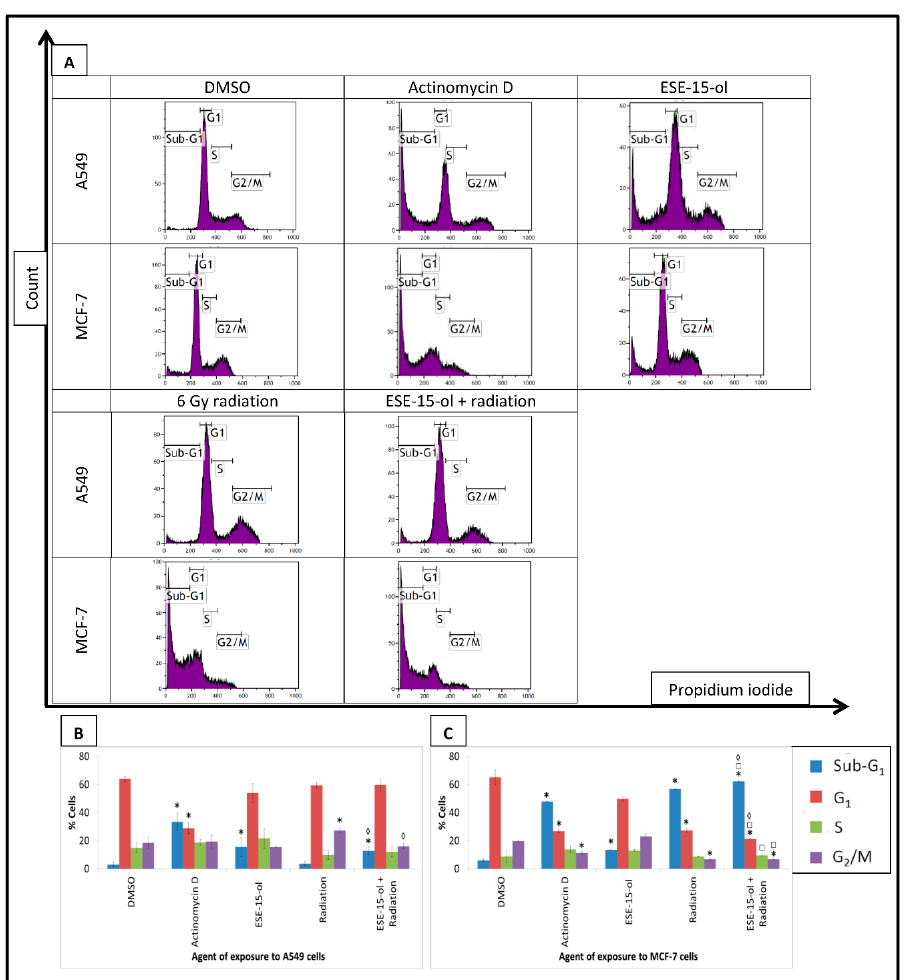
Figure 2. Cell cycle analysis of A549- and MCF-7 cells. Propidium iodide (FL3) was plotted against number of fluorescent events to analyze the cell cycle distributions. ( A ) Dot plots of A549 and MCF-7 cells exposed to ESE-15-ol for 24-h, 6 Gy radiation, and the combination treatment condition. DMSO served as a vehicle control and actinomycin D as a positive method control for apoptosis. Presensitized MCF-7 cells displayed a more prominent increase in sub-G 1 and a decrease in G 1 when compared to cells exposed to ESE-15-ol and 6 Gy radiation. Graphical representations of A549 dot plots ( B ) and MCF-7 dot plots ( C ). Bars indicate the average of three biological repeats, with standard deviation represented by T-bars. Statistical significance ( p -value < 0.05) represented by * when compared to DMSO, □ when compared to ESE-15-ol treated samples, ◊ when compared to radiation treated samples.